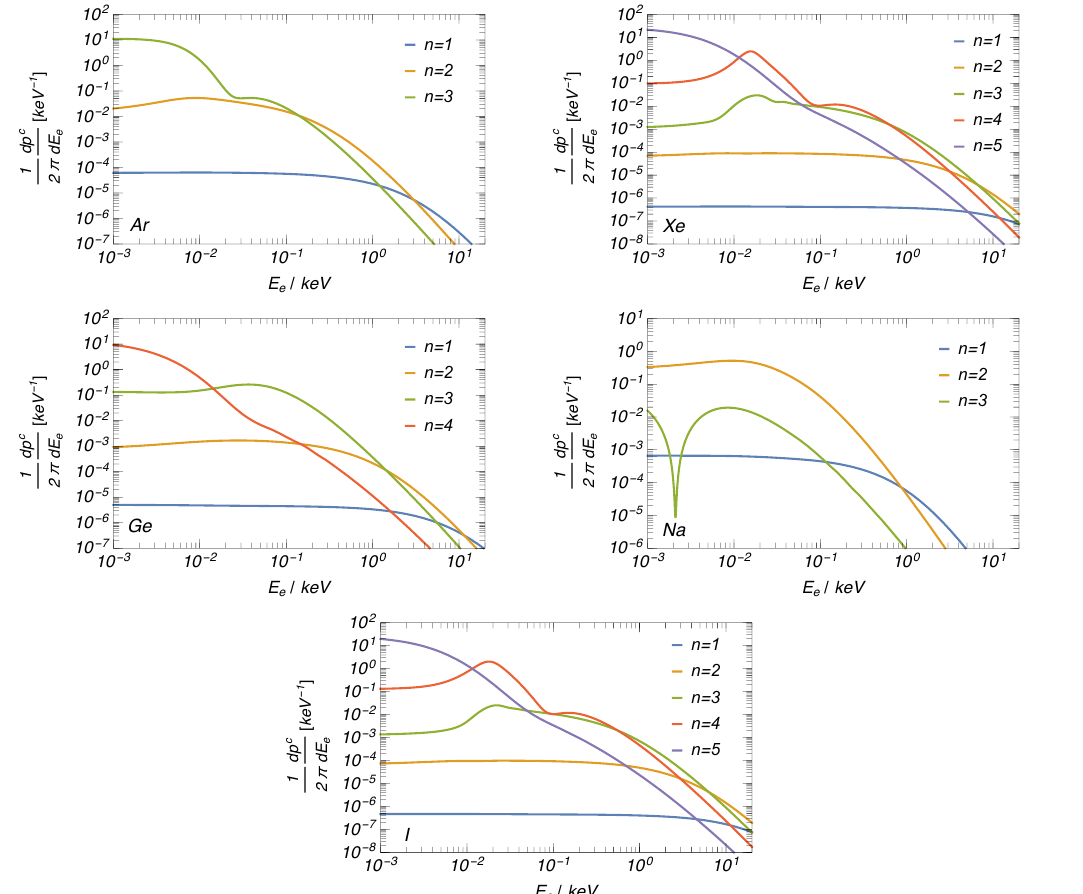
Figure 4 . The di(cid:11)erential ionization probabilities as a function of the emitted electron energy, E e , for isolated Ar , Xe , Ge , Na , and I . The contributions from di(cid:11)erent ‘ ’s are summed. We also summed all the possible (cid:12)nal states for a given n . The integrated probabilities are given in table 2.